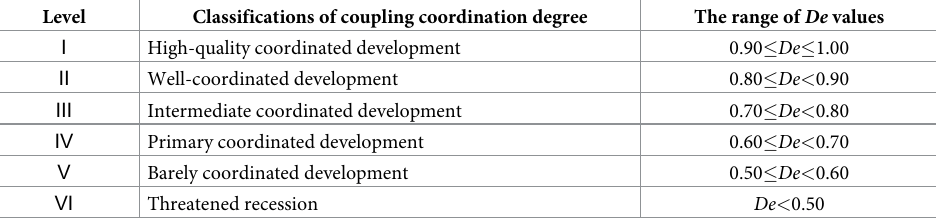
Table 4. Classification of coupling coordination degree.